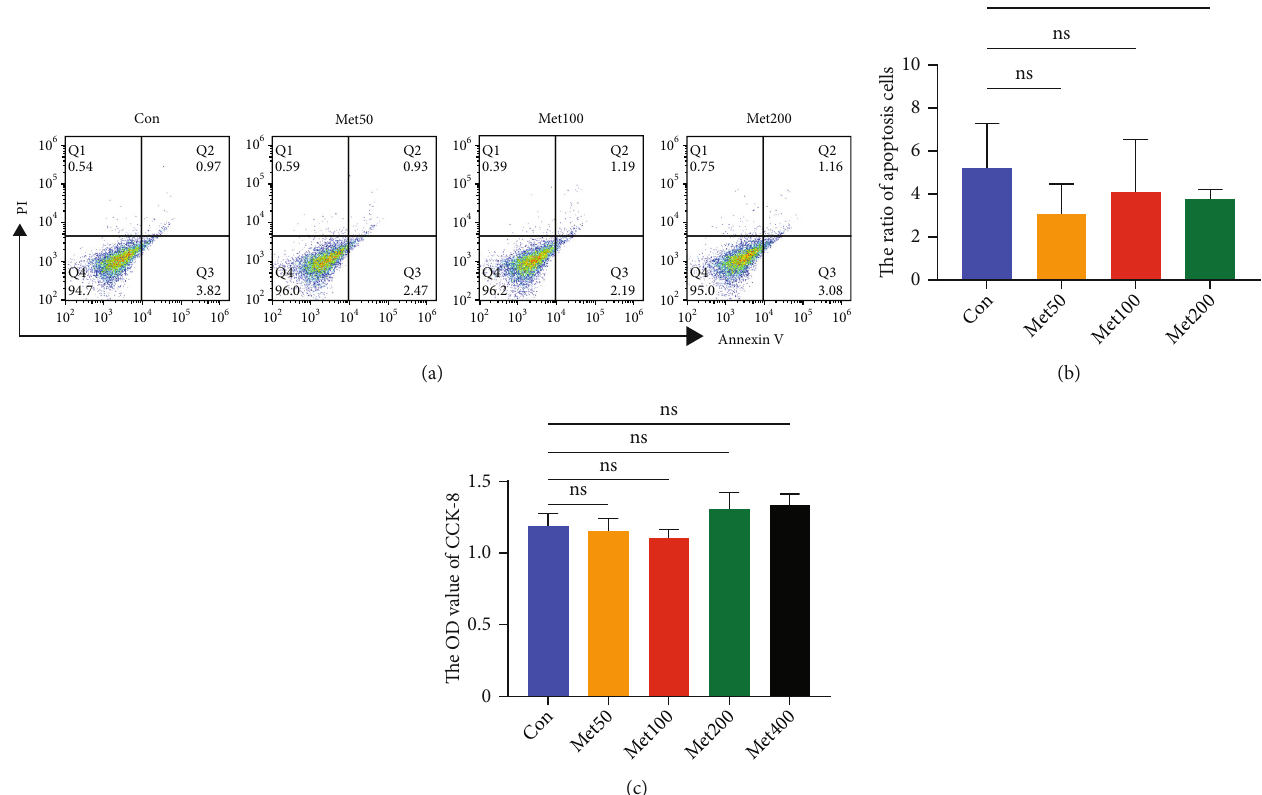
Figure 2: Metformin did not in fl uence the proliferation of UC-MSCs in vitro. (a, b) Representative graphs and statistical analysis of Annexin V/PI double staining were displayed. (c) The OD value of CCK-8 after di ff erent concentrations of metformin (0, 50, 100, 200, and 400 μ M) for 48 h. Data were expressed as mean ± SD from three independent experiments. Met: metformin; ns: no signi fi